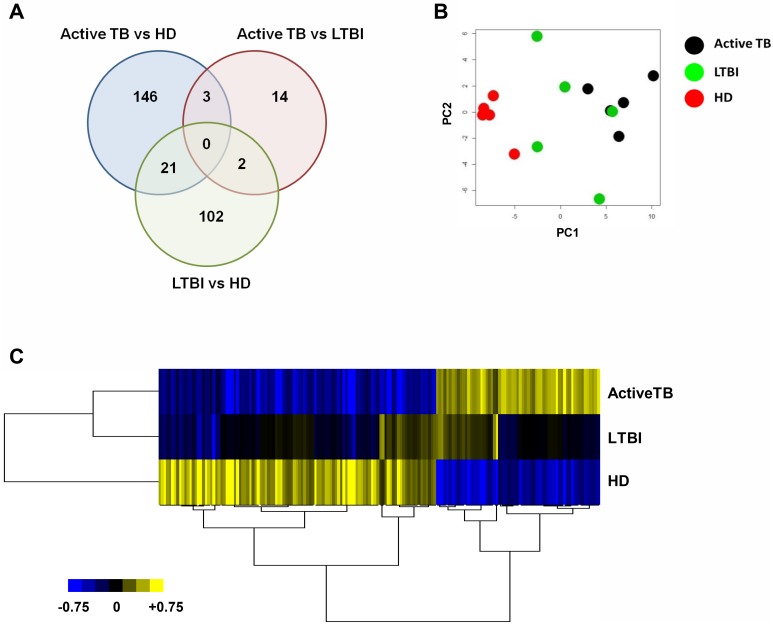
Analysis of differentially expressed genes across active TB, LTBI and HD individuals.Hereafter, active TB, LTBI and HD indicate TB-DCs, LTBI-DCs and HD-DCs, respectively. A, Venn’s diagram showing the number of transcripts modulated and their overlaps across IFN-DCs derived from active TB, LTBI and HD individuals. Genes selected on the threshold of P <0.005 by Student’s t-test from five biological replicates (n = 5) for each group were included in the analysis. B, PCA of differentially expressed genes across active TB, LTBI and HD; PC1 and PC2 were chosen as the axes explicating most of the data variance. C, Heat map showing differential expression across active TB, LTBI and HD, built on the selected 170 genes differentially expressed between active TB and HD individuals. The expression level average of five samples for each group is shown. Values are average corrected and shown on a blue-black-yellow gradient: yellow, increased expression; blue, decreased expression.